Question: How would you classify this visualization?
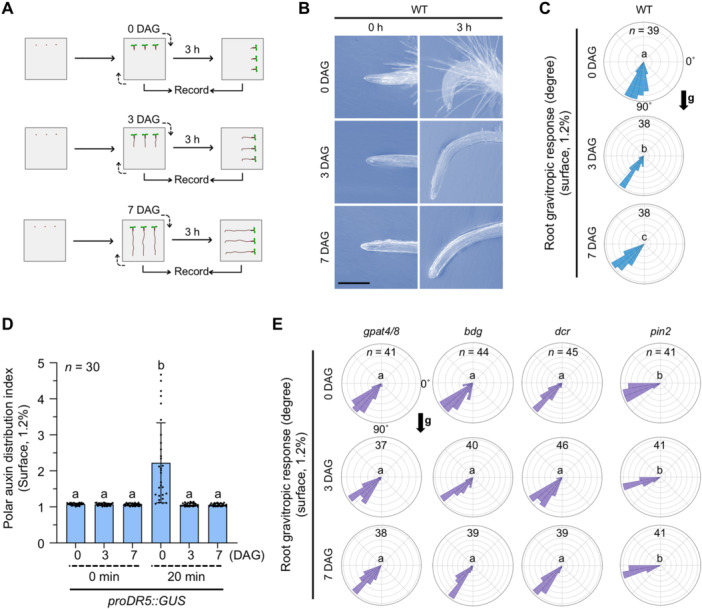
Answer: histogram